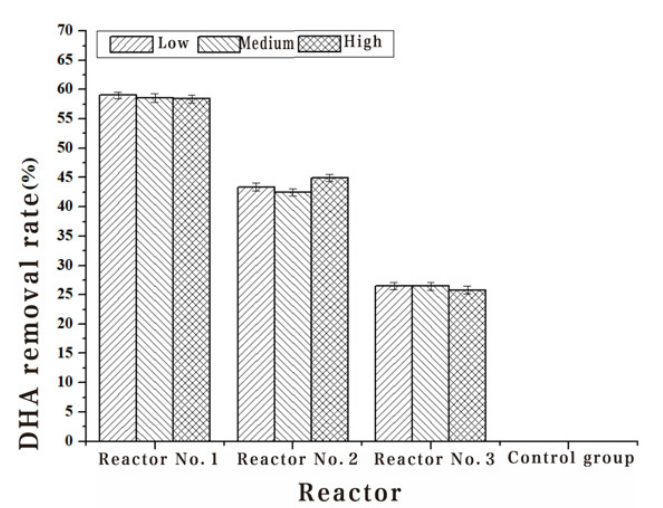
Figure 3. Effect of three addition methods with Phanerochaete chrysosporium on DHA. Table 4. The protein content variation in three addition methods with Phanerochaete chrysosporium .